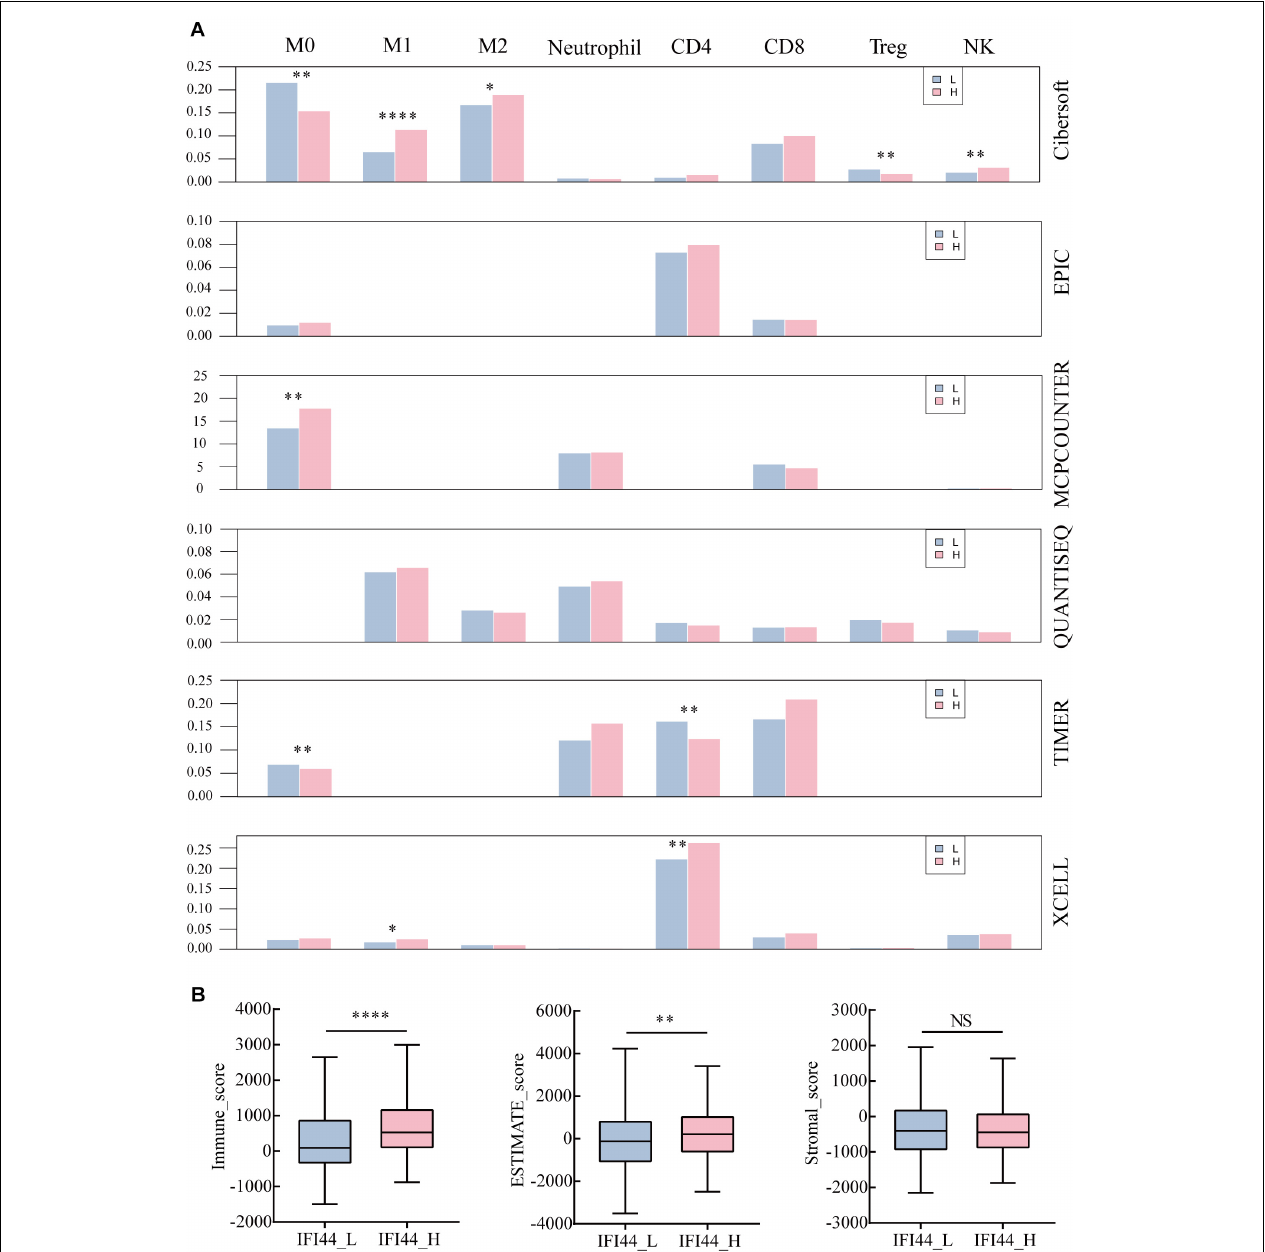
FIGURE 5 | The different immune infiltration in IFI44-high expression group and IFI44-low expression group. (A) The immune infiltration of analysis across six databases between IFI44-high expression group ( n = 261) and IFI44-low expression group ( n = 261). M0 (macrophage M0), M1 (macrophage M1), M2 (macrophage M2), CD4 (CD4 + T cell), CD8 (CD8 + T cell), Tregs (regulatory T cells), NK (natural killer cell). (B) The immune infiltration score including immune score, stromal score, and estimate score in IFI44-high expression group ( n = 261) compared with IFI44-low expression group ( n = 261). The analysis was conducted in ESTIMATE database (* P < 0.05; ** P < 0.01; *** P < 0.001; **** P <